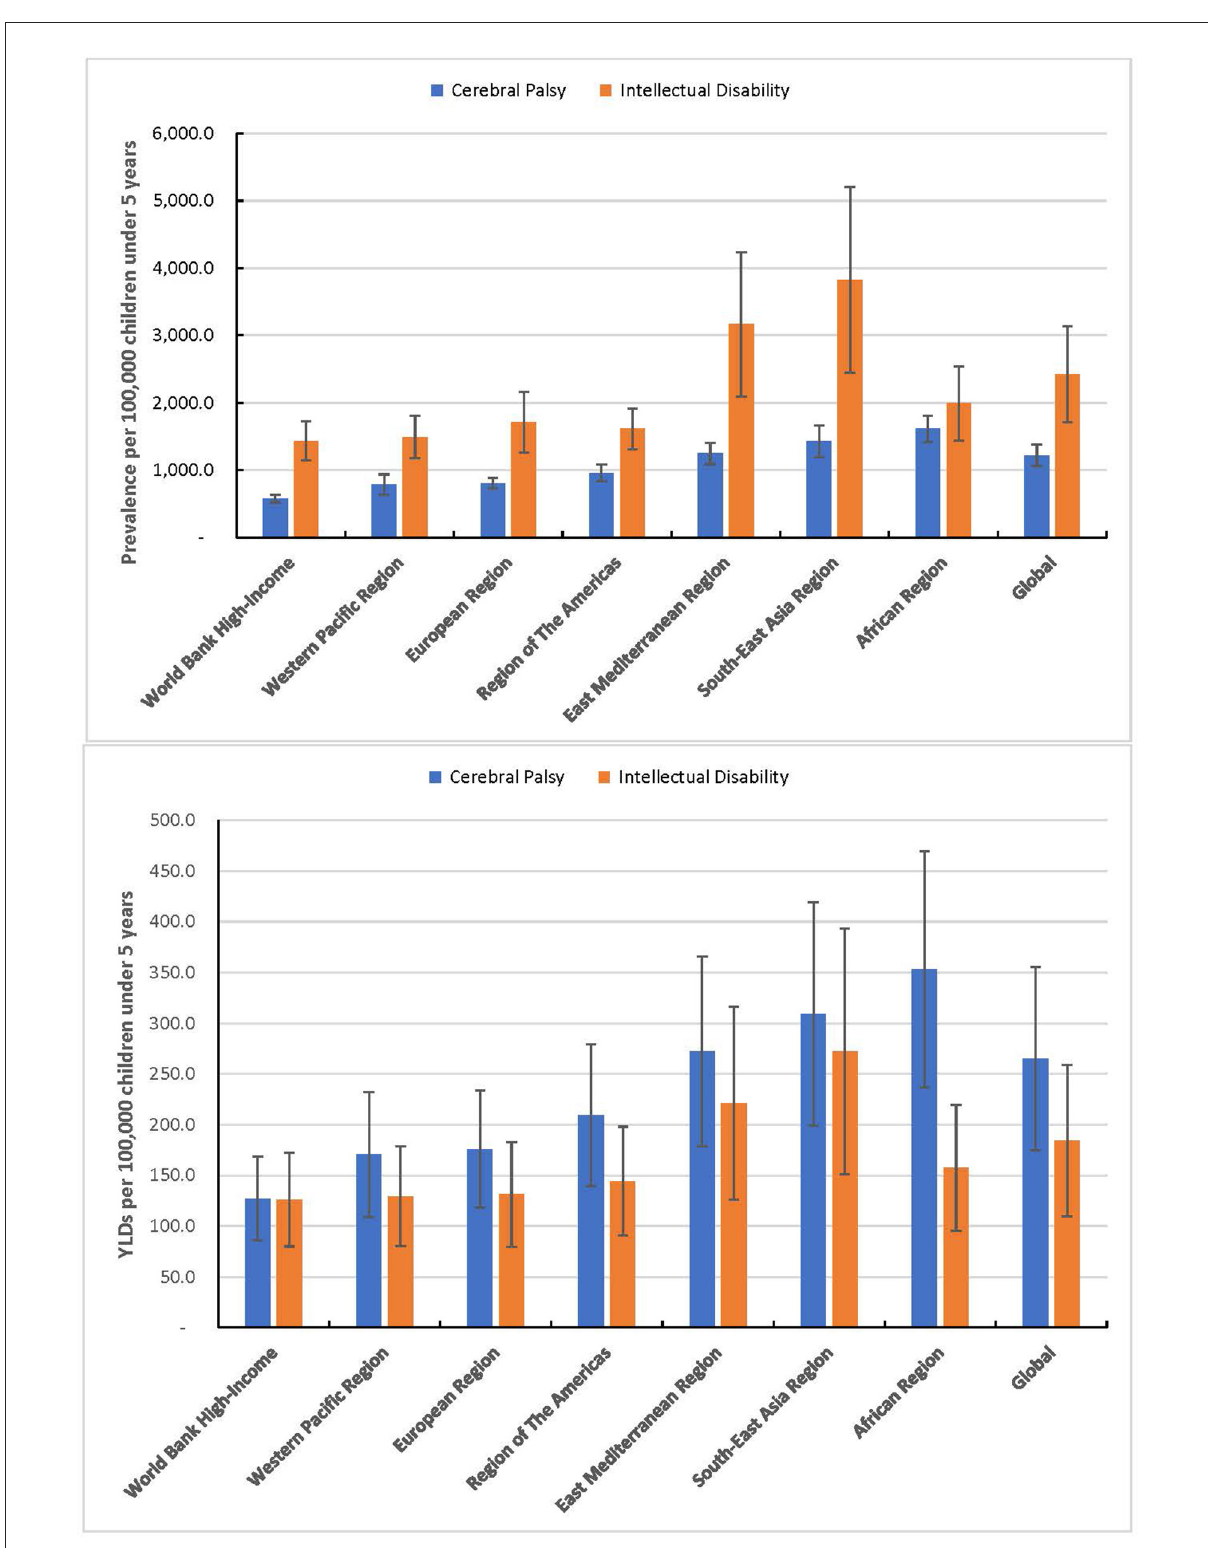
FIGURE1 Global and regional prevalence of cerebral palsy and developmental intellectual disability and the YLDs among children under 5 years in